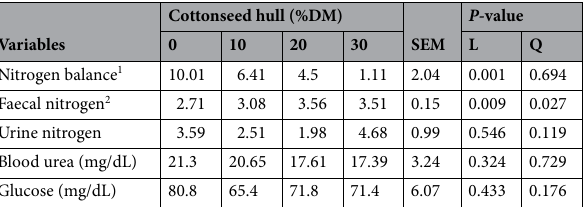
Table 2. Nitrogen balance and blood metabolites of rams fed with cottonseed hull levels. 1 Y = 10.13–0.51X; 2 Y = 2.78 + 0.04X.